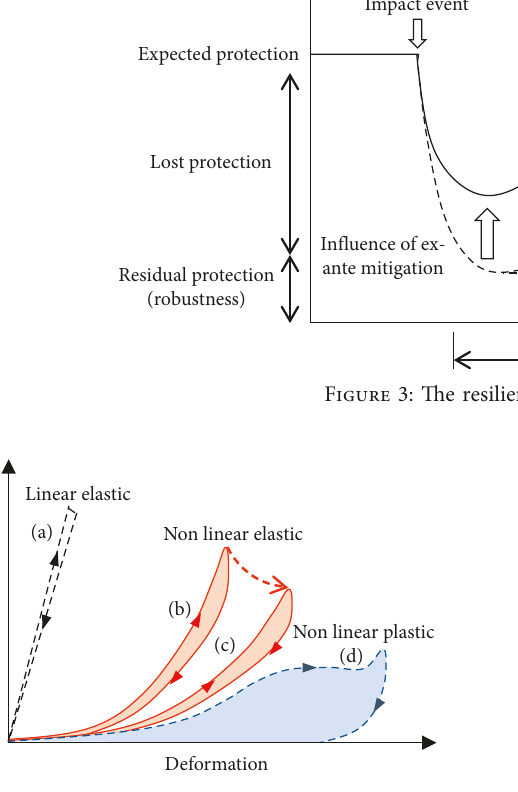
Figure 4: Typical performance curves of buffer layers/structures.